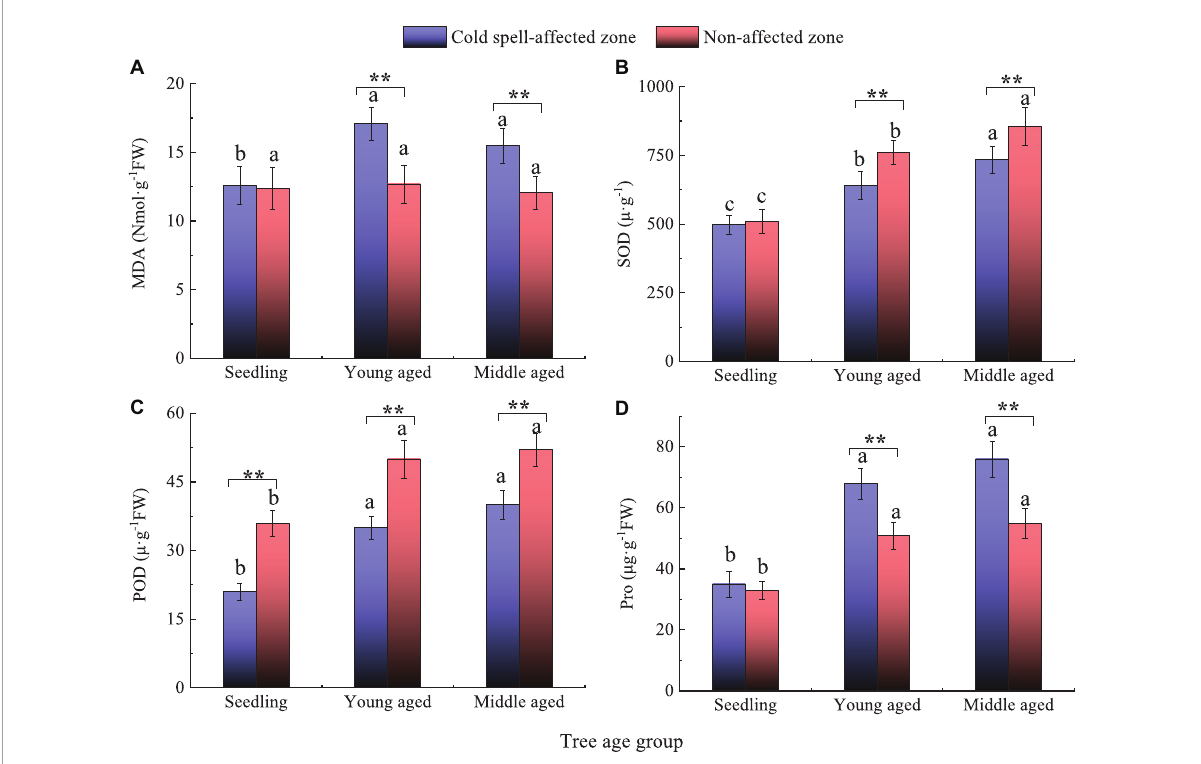
FIGURE3 Leaf biochemical compounds and oxidative stress response in the cold spell impacted and non-impacted zones. Different lowercase letters indicated significant differences between cohorts ( P < 0.05). Asterisks with brackets indicate significant differences between cold spell impacted zone and non-impacted zone within the cohort (* P < 0.05; ** P < 0.01). (A) malondialdehyde (MDA); (B) superoxide dismutase (SOD); (C) peroxidase (POD); (D) free proline (Pro).